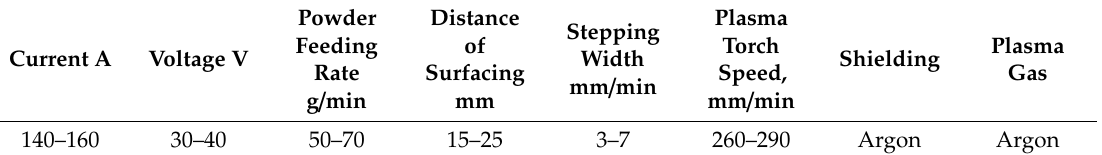
Table 3. Plasma surfacing parameters.